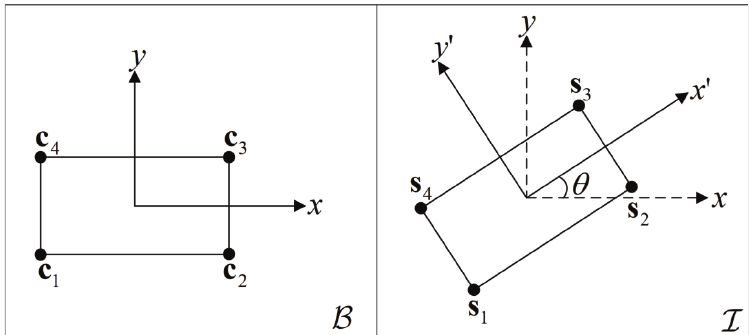
Figure 2. 2–D scenario of the rigid body rotation